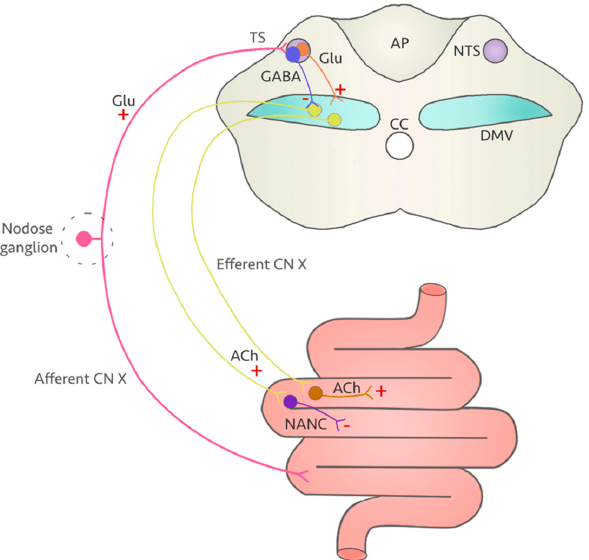
Figure 1. Diagram showing the vagal neurocircuitry regulating gastrointestinal (GI) tract regulation from the vagus nerve. Sensory signals from the GI tract notify the central nervous system (CNS) of the presence or absence of food through vagal afferents (pink), whose cell bodies reside in the nodose ganglion. Once activated, these sensory afferent neurons release glutamate through the Tractus Solitarius (TS) into the Nucleus of the Tractus Solitarius (NTS; light purple). The NTS then relays the peripheral information to the motor branch of the vagus nerve by modulating the activity of the pacemaking neurons within the Dorsal Motor Nucleus of the Vagus (DMV, teal). The main neurotransmitter released by the NTS is the inhibitory GABA (blue neuron, minus sign), but the excitatory glutamate can also be released (orange neuron, plus sign). Once activated, DMV neurons (yellow) release acetylcholine to their targets within the GI tract, namely neurons of the myenteric plexus. These are either excitatory cholinergic (gold neuron, plus sign) or inhibitory Non-Adrenergic Non-Cholinergic (NANC; purple neuron, minus sign) neurons. The fine balance between GABA and glutamate at the NTS to DMV synapse together with the balance of the cholinergic and NANC signaling in the myenteric plexus ensures that digestion is only activated when food is present in the GI tract. Abbreviations: ACh, acetylcholine; AP, Area Postrema; CC, Central Canal; CN X, Cranial Nerve X; DMV, Dorsal Motor Nucleus of the Vagus; Glu, glutamate; NANC, Non Adrenergic Non Cholinergic; NTS, Nucleus of the Tractus Solitarius; TS, Tractus